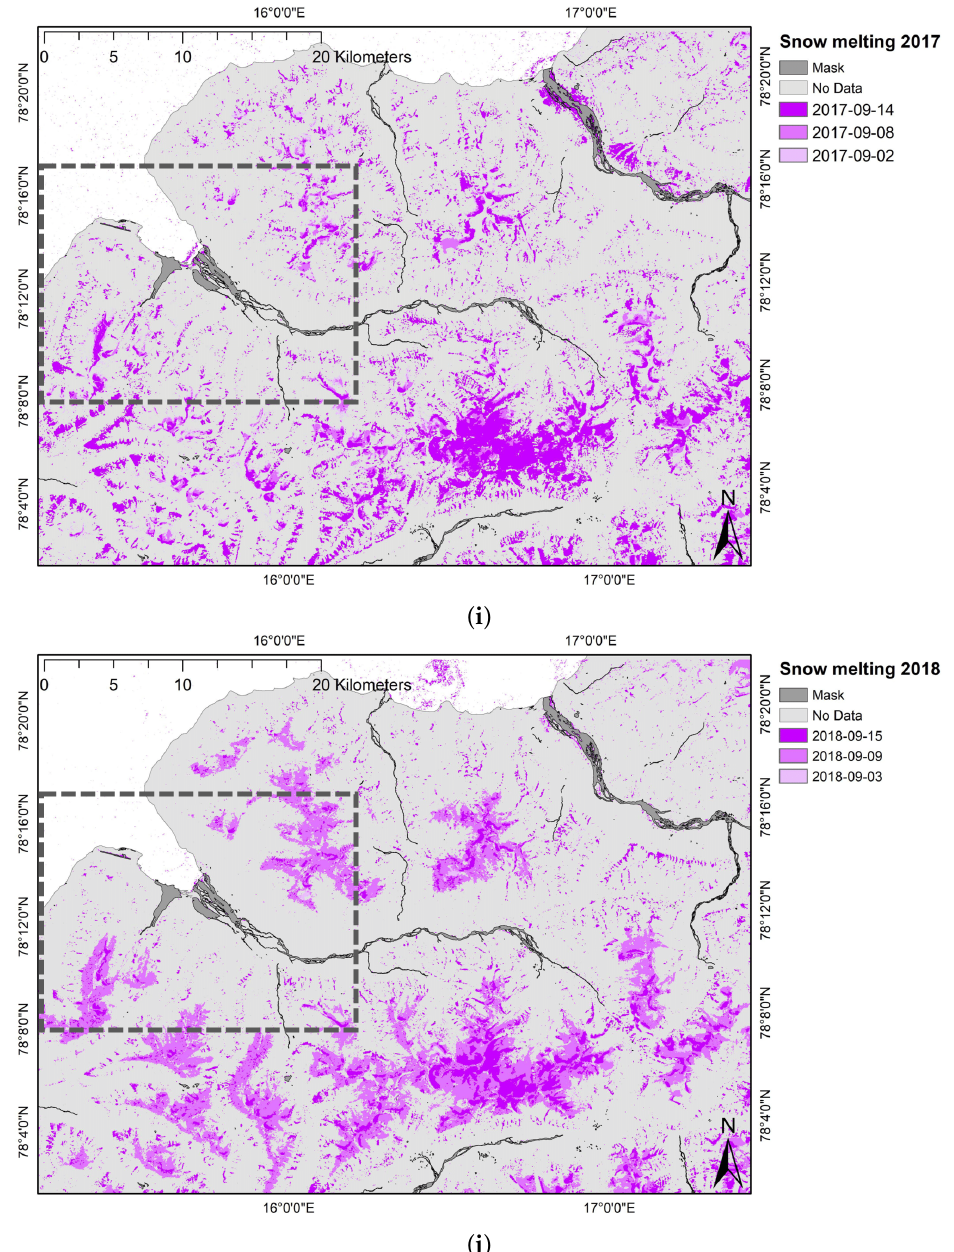
Figure A1. Wetsnow masks of the season 2017 and 2018: May is shown in blue ( a , b ), June in red ( c , d ), July in orange ( e , f ), August in green ( g , h ) and September in purple ( i , j ). The masks of the different days of the months are overlapped by a dark to light gradient for each type of color (cumulative of month periods). The picture shows the surrounding area of Adventdalen to provide an overview of the region, with a dotted frame representing the investigated